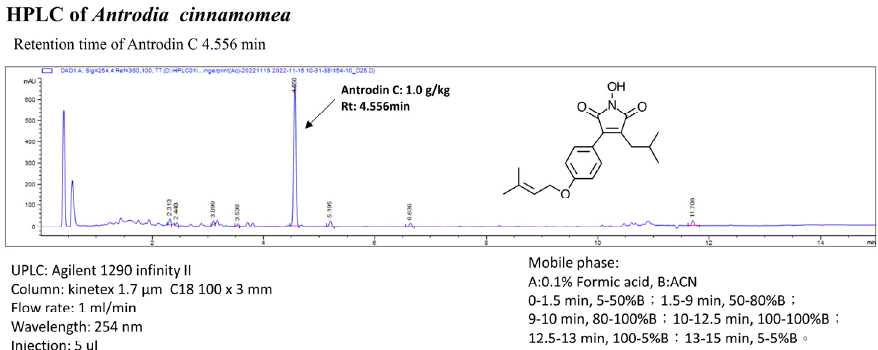
Figure 1. High-performance liquid chromatography analysis of the ethanol Antrodea cinnamomea mycelial extract. The retention time peak of antrodin C from the bioreactor is at 4.556 min (UV detection at 254 nm).